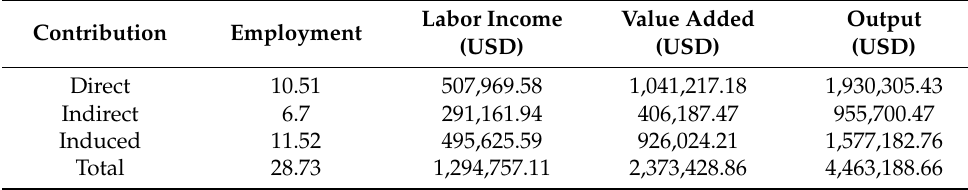
Table A9. Contribution of Rookery Bay Spending to Lee and Collier Counties (Annual).